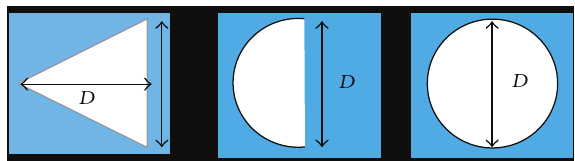
Figure 6: Pin fins element configurations employed in the investi- gation by Siw et al. [9].